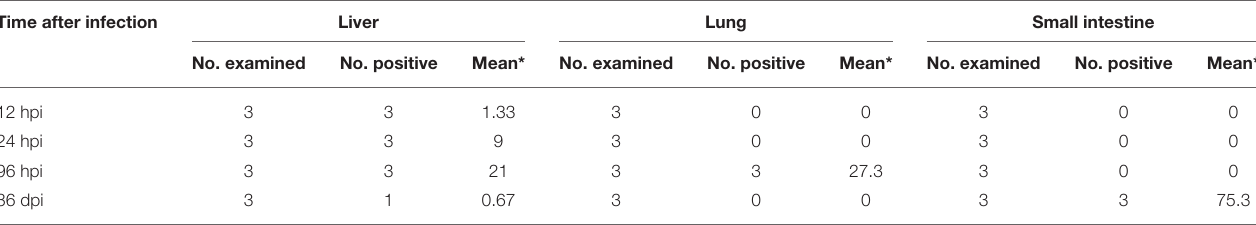
TABLE 1 | The recovery of Toxocara canis larvae from the liver, lung, and small intestine of infected puppies at four time points post-oral infection with 300 infectious T. canis eggs. Time after